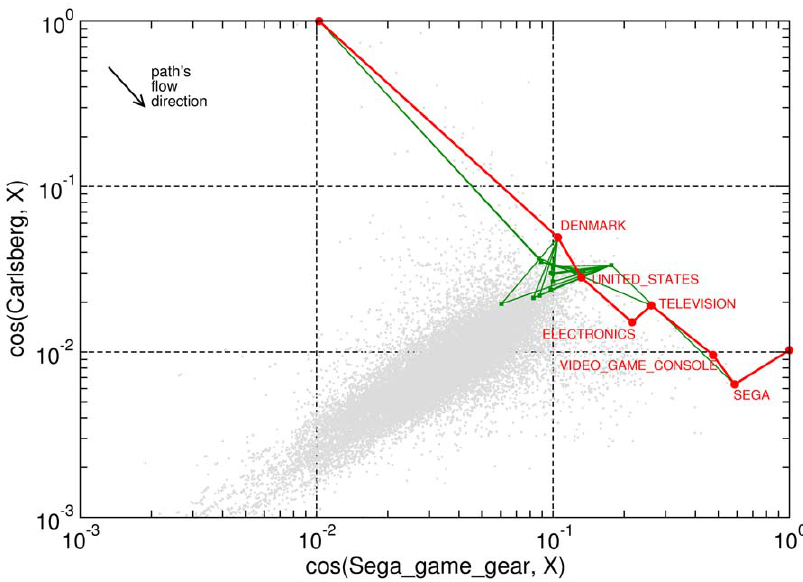
Figure 5. Similarity to target (Carlsberg) vs. similarity to source (Sega_Game_Gear). In this example, our semantic path (red) is comprised by 8 jumps whereas shortest paths (green) involve 6 steps ( 13 -fold degenerated). However, a slight efficiency loss can be compensated by a truly coherent path. Observe how the shortest path decreases its similarity to the target at some intermediate points. At these points, shortest paths navigate through hubs (like September_7 or 1999) which exhibit shallow similarities with source and target, but help to reach the target in a small number of steps. The remaining similarity pairs with the rest of nodes are depicted as a scatter plot.